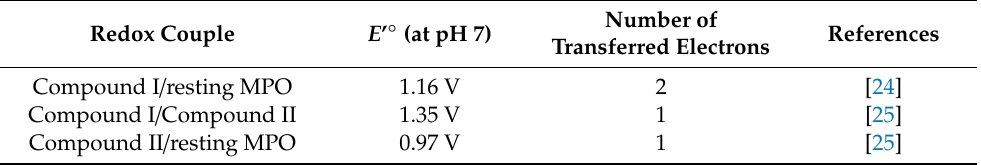
Table 2. Standard reduction potentials ( E ’ ◦ ) for the interconversion between heme states of human myeloperoxidase. Redox Couple E ’ ◦ (at pH